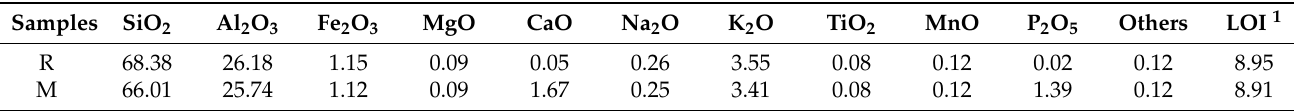
1 Loss on ignition.